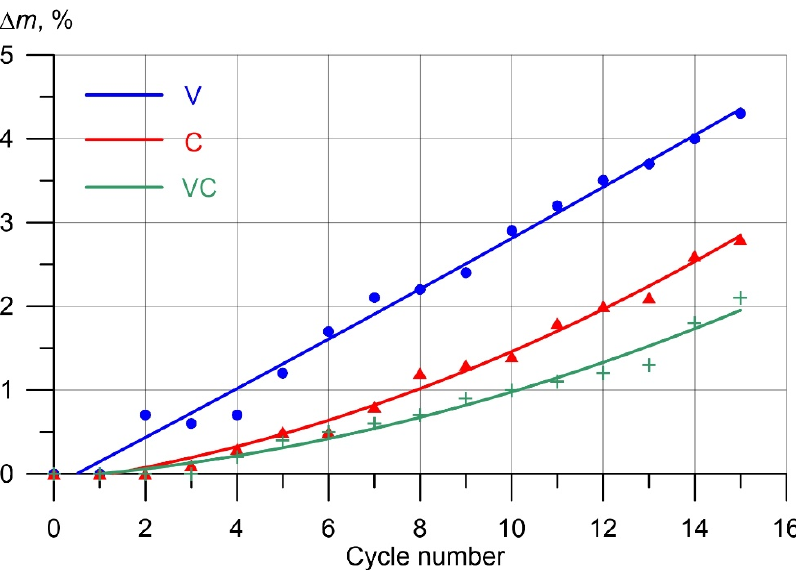
Figure 7. Weight loss of vibrated (V), centrifuged (C), and vibrocentrifuged concrete (VC) samples depending on the number of freeze and thaw cycles.